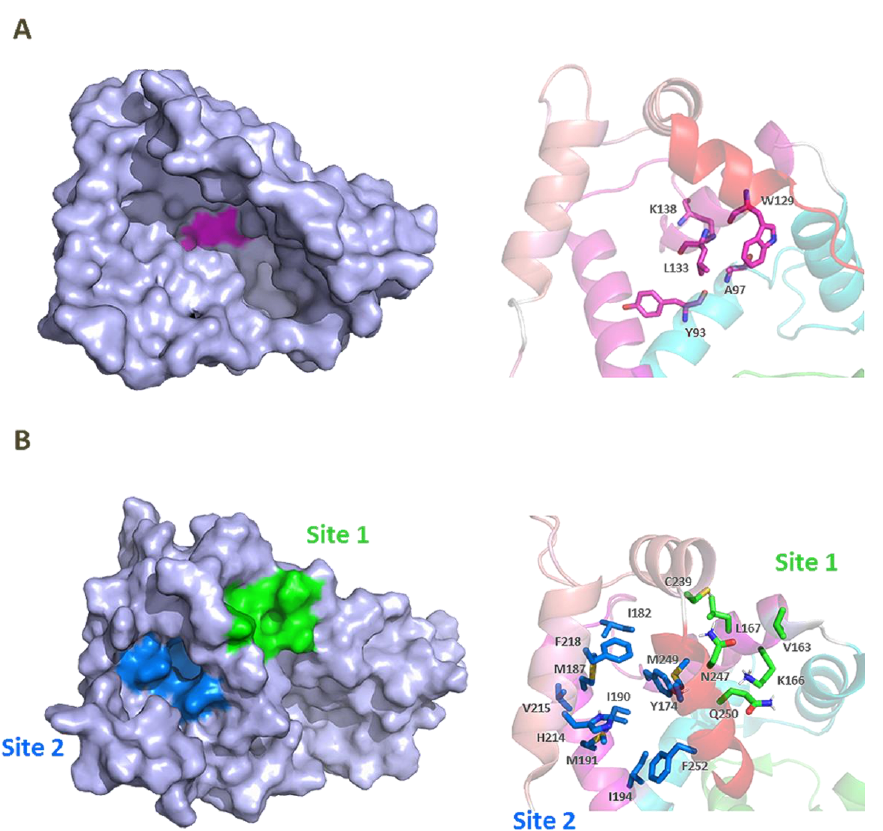
Figure 6. Cartoon and surface representation of ( A ) KChIP1 (PDB ID 2I2R) residues suggested by molecular modeling to be involved in CL-888 binding [59]. ( B ) KChIP3 (PDB ID 2JUL) residues suggested by molecular modeling to participate in 8-anilino-1-naphthalene sulfonate (1,8- ANS) binding [62].